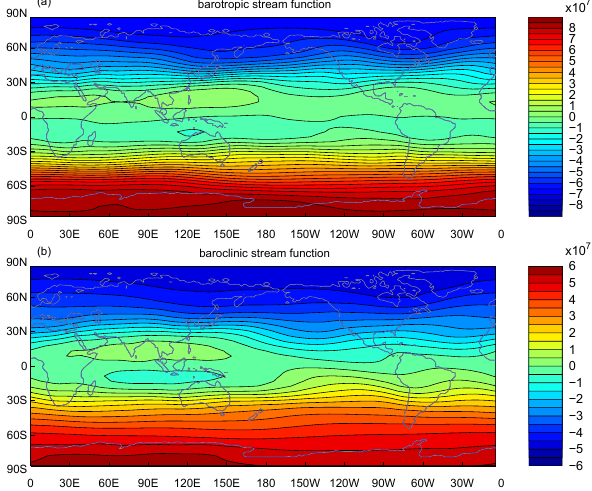
Figure 2. (a) Barotropic and (b) baroclinic stream functions of the climatology. The contour interval is 5.0 × 10 6 m 2 s − 1